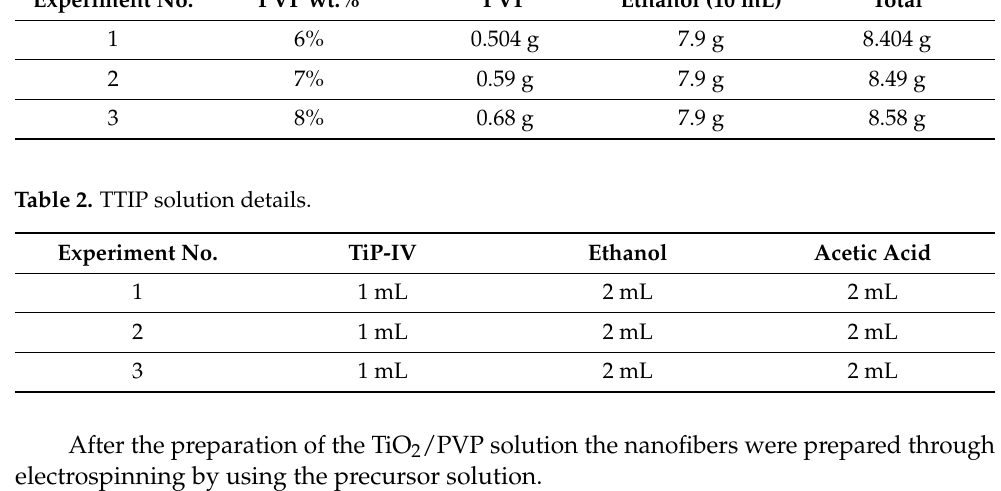
Table 1. PVP solution details. Experiment No.